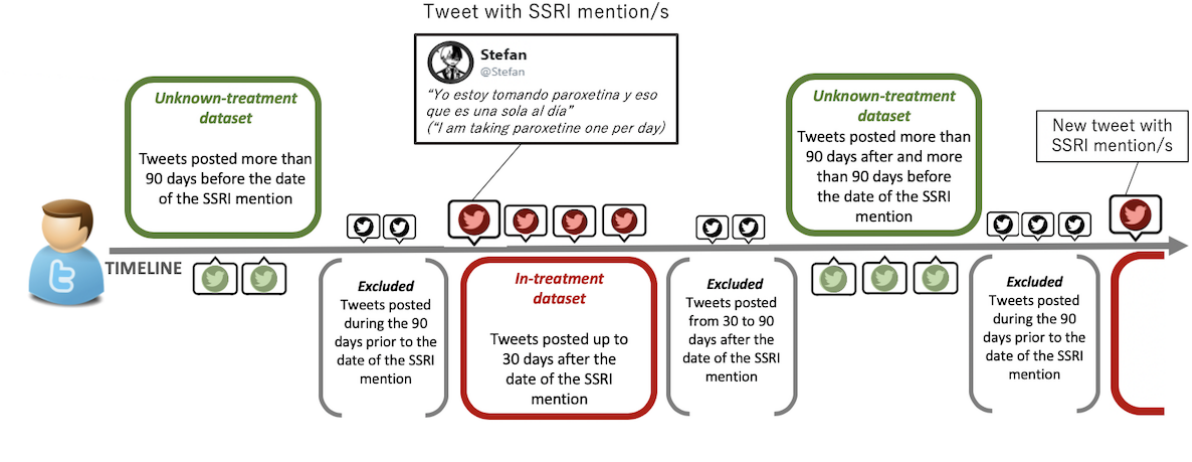
Table 1. Selective serotonin reuptake inhibitors (SSRIs) used in the study.